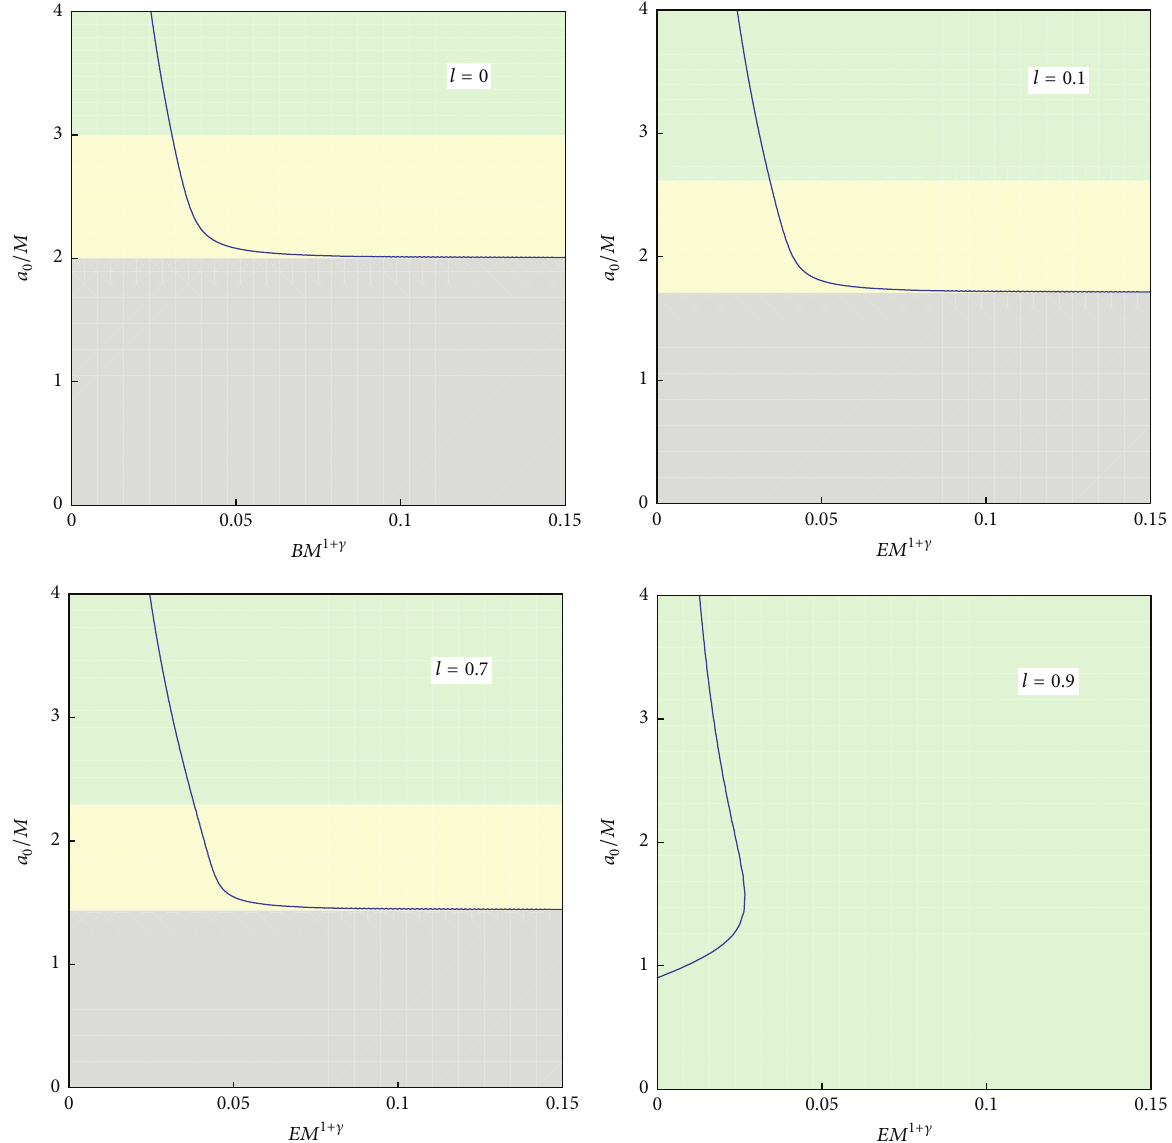
Figure 5: Plots for GCCG with parameters 𝛾 = 0.2 , 𝑀 = 1 , and 𝑤 = −10 and different values of 𝑙 . Here, 𝐸𝑀 (1+𝛾) and 𝑎 0 /𝑀 are labeled along abscissa and ordinate,